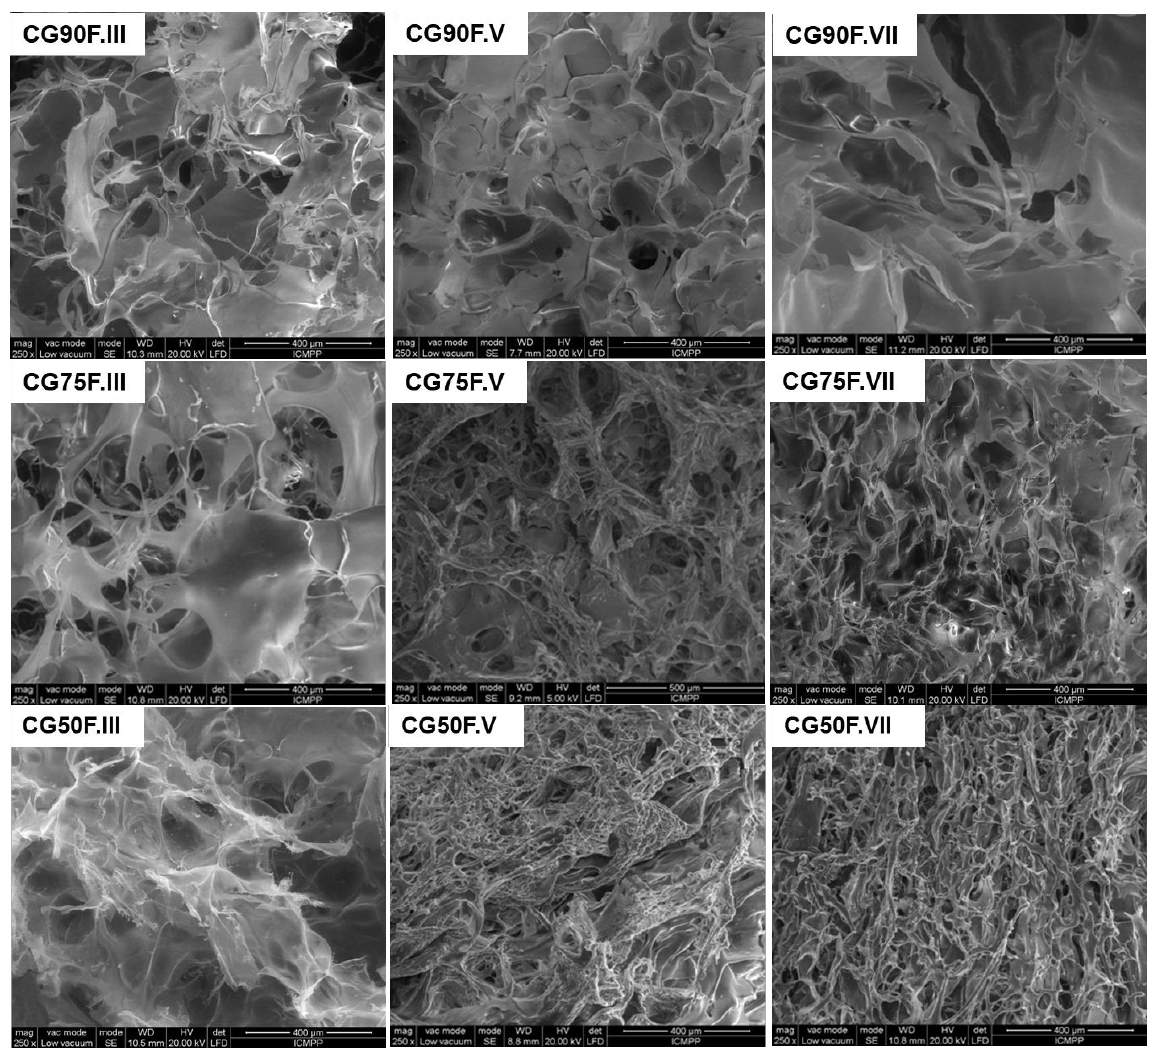
Figure 4. SEM micrographs of the lyophilized XG - based composite hydrogels.